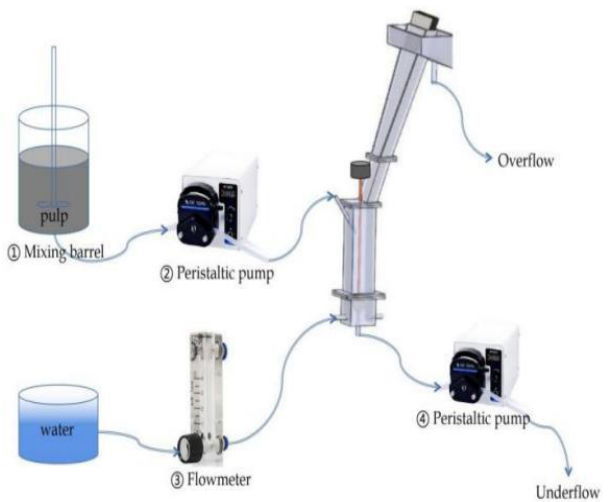
Figure 4. Experiment